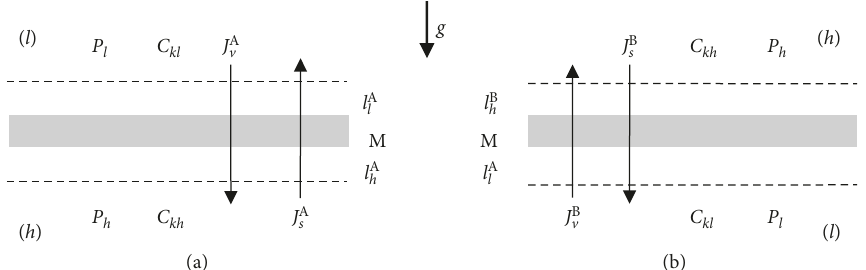
l A l and h , the concentration boundary layers in configuration A;